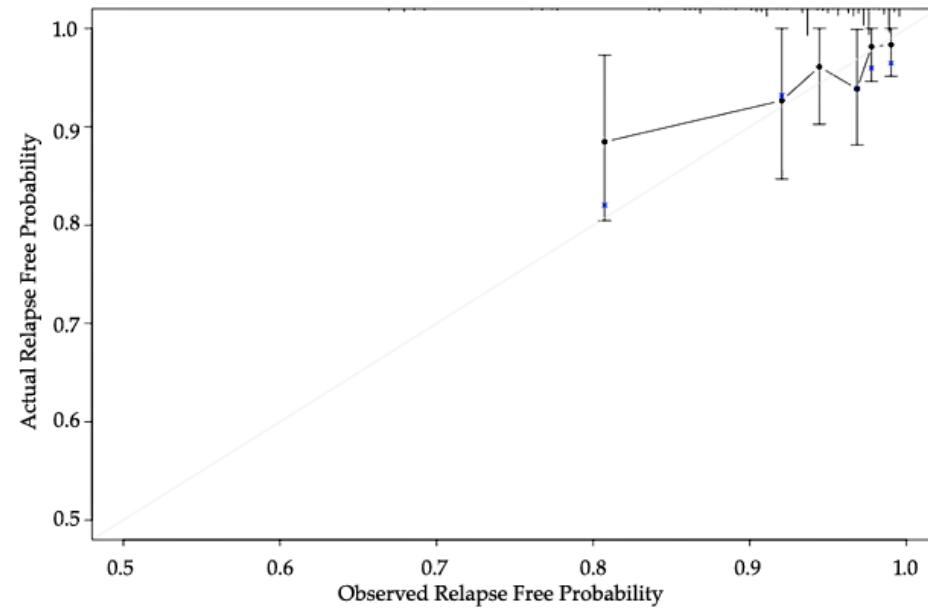
Figure 2. Calibration of the PCO classifier application.